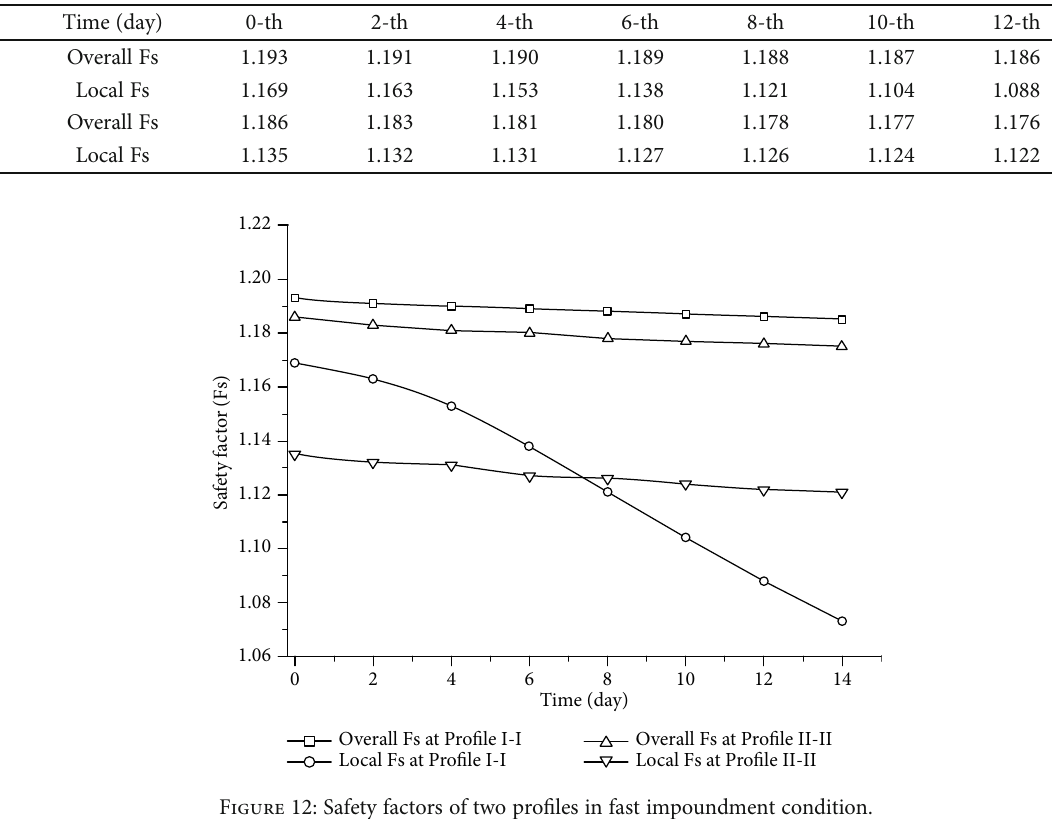
Table 4: The safety factor of the pro fi les during the rapid drawdown condition.